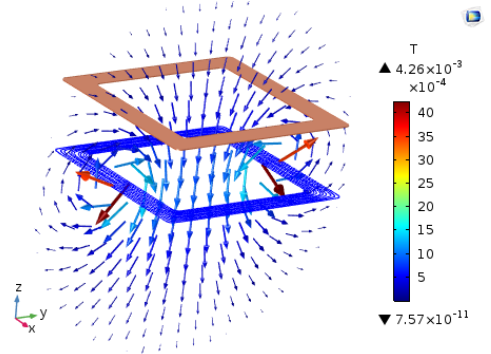
Figure 7. Current and magnetic flux density distribution in 3D.